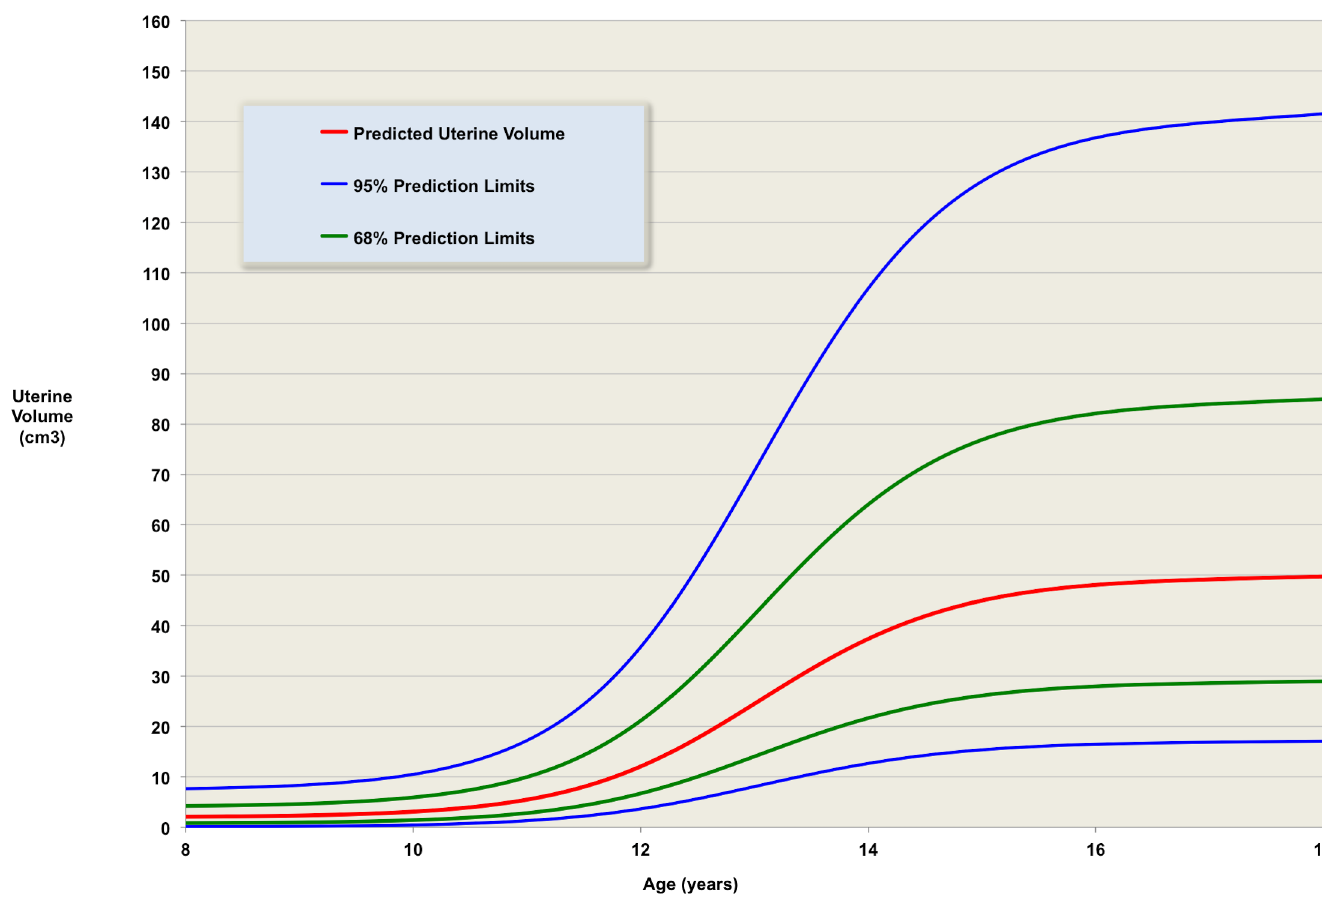
Fig 5. The validated model. Predicted uterine volume for ages from 8 to 18 years, with one and two standard deviations prediction limits – 68% of measurements at a given age are expected to be between the green lines; 95% are expected to be between the blue